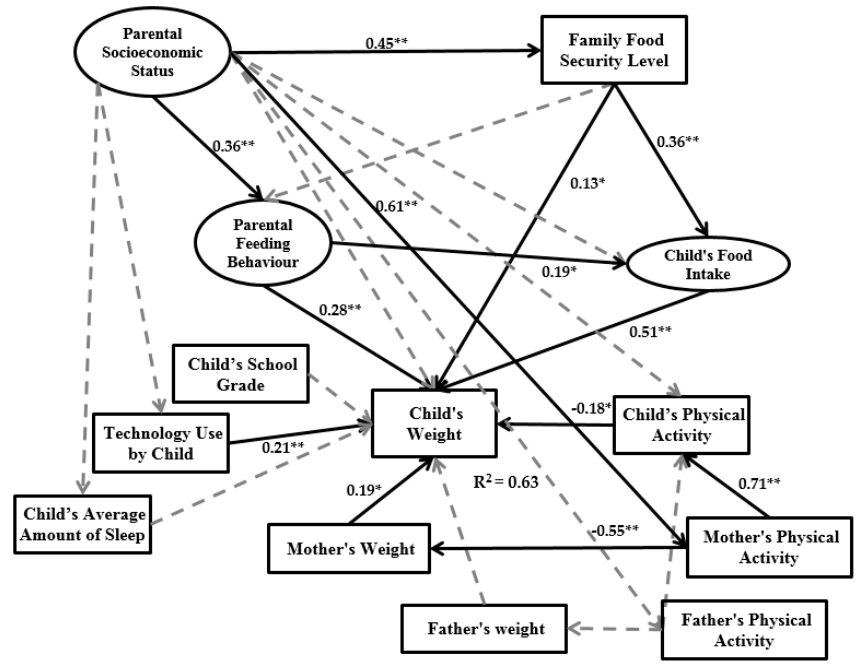
Figure 5. Normal model output (* Significant in the level of 5%; ** Significant in the level of 1%).